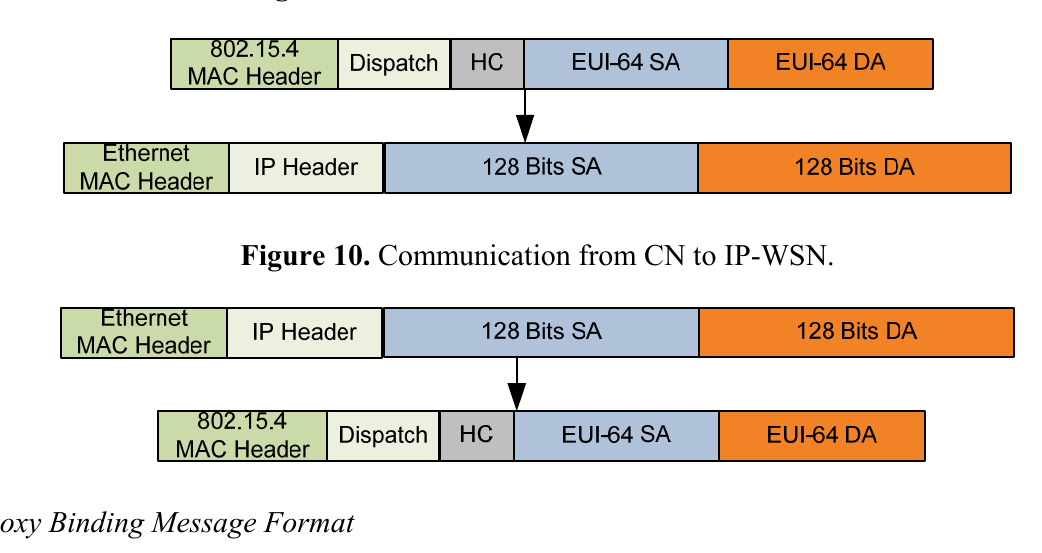
Figure 9. Communication from IP-WSN to CN.